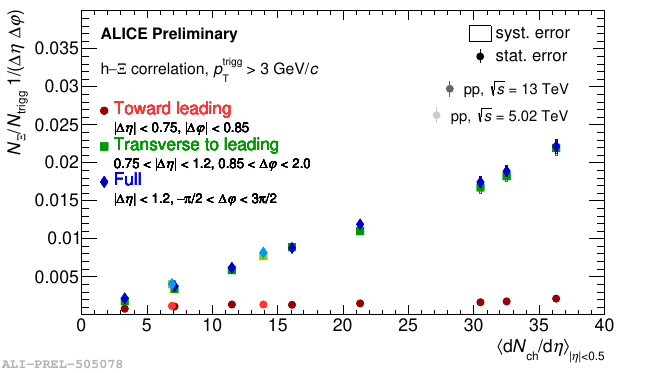
Figure 3. Distribution of yield per trigger particle and syst. error syst. error syst. error per unit of ( ∆ η, ∆ φ ) of stat. error stat. error stat. error Ξ baryons as a function of the charged particle multiplicity at midrapidity: full yield in blue diamonds, toward the leading jet yield in red circles, and transverse to the leading jet yield in green squares. Results for pp at √ s = 13 TeV are in dark colors, and pp at √ s = 5 TeV in light